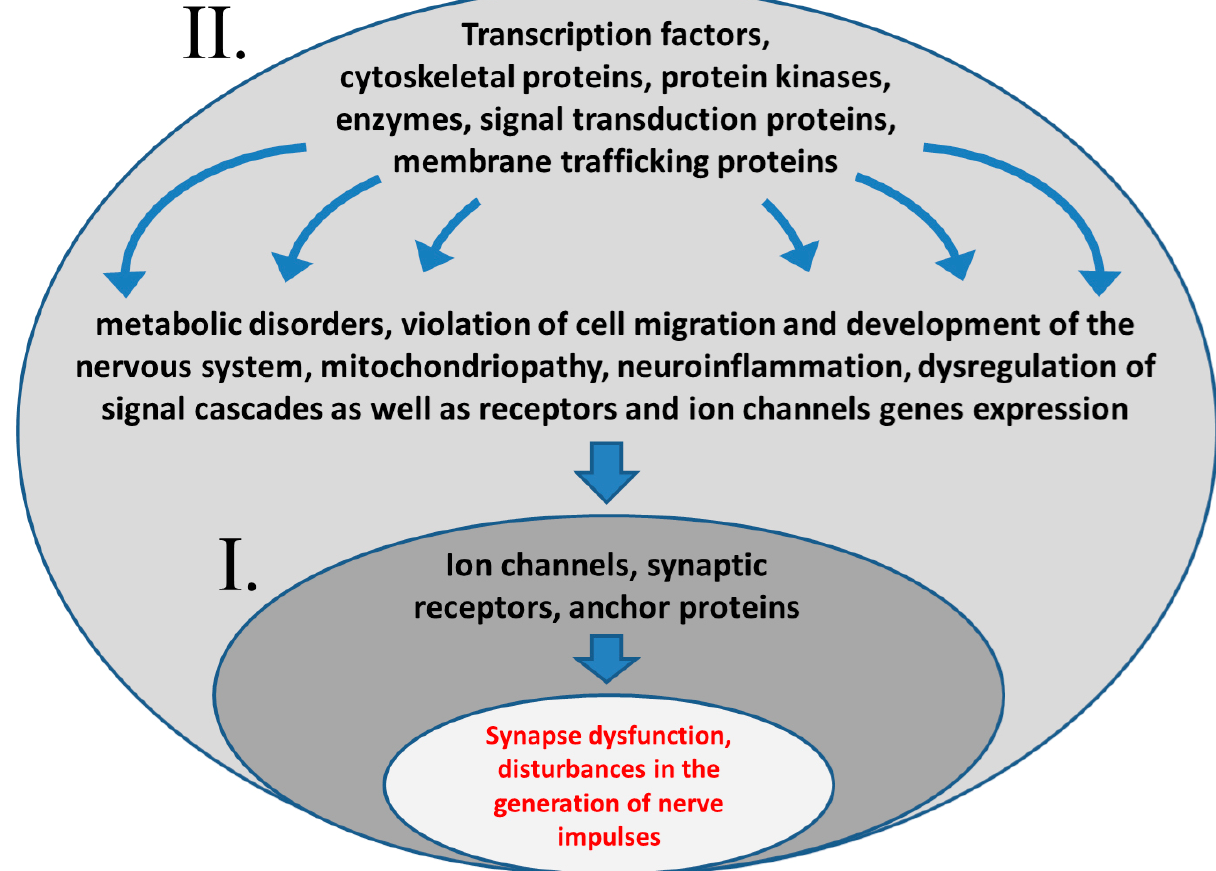
Figure 1. Mutations leading to the development of epilepsy may affect genes directly involved in the generation and transmission of nerve impulses (group I), or genes responsible for the devel- opment and metabolism of the nervous system (group II). In the second case, violations of the functions of ion channels and specific synaptic proteins occur indirectly. ion channels and specific synaptic proteins occur